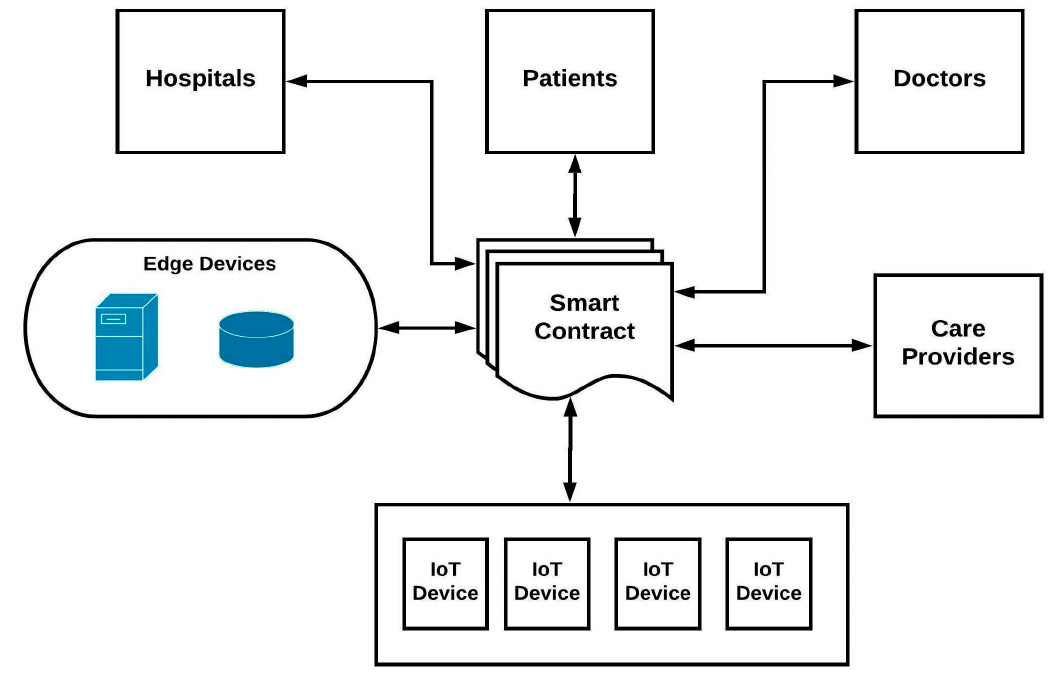
Figure 5. Smart contract in SMS.